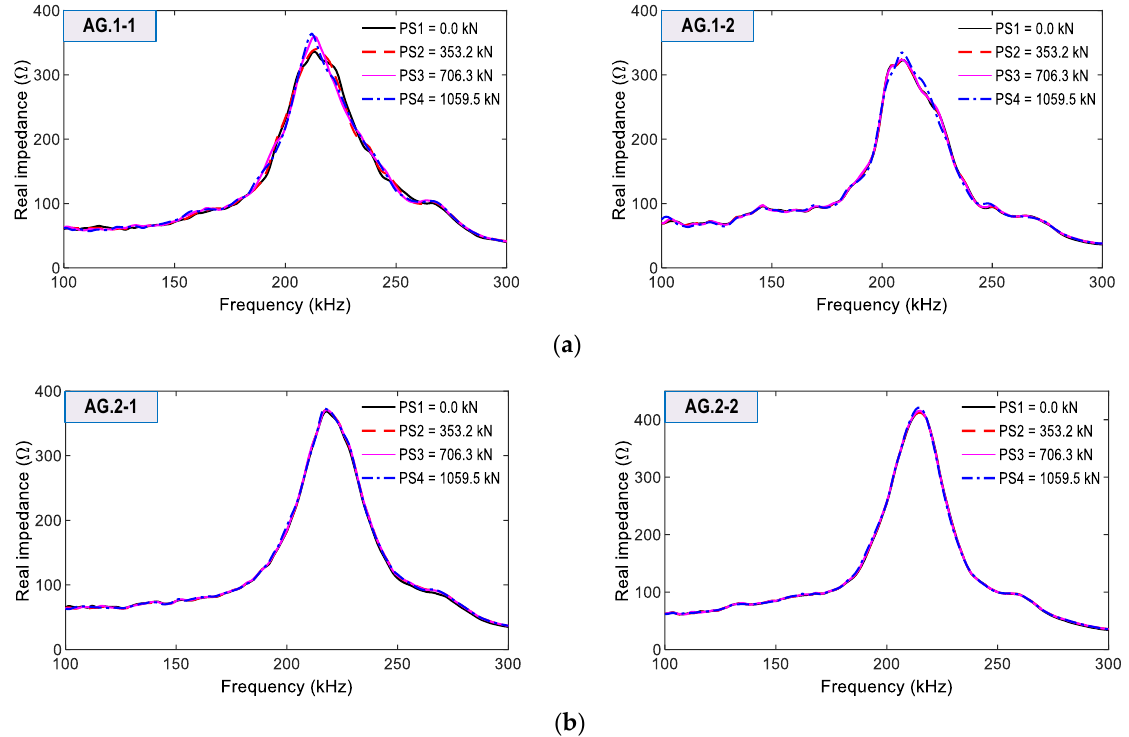
Figure 20. Impedance signatures of smart aggregates for loading cases PS1~PS4: ( a ) Smart aggregates AG.1-1 and AG.1-2 on Rebar 1; ( b ) Smart aggregates AG.2-1 and AG.2-2 on Rebar 2.